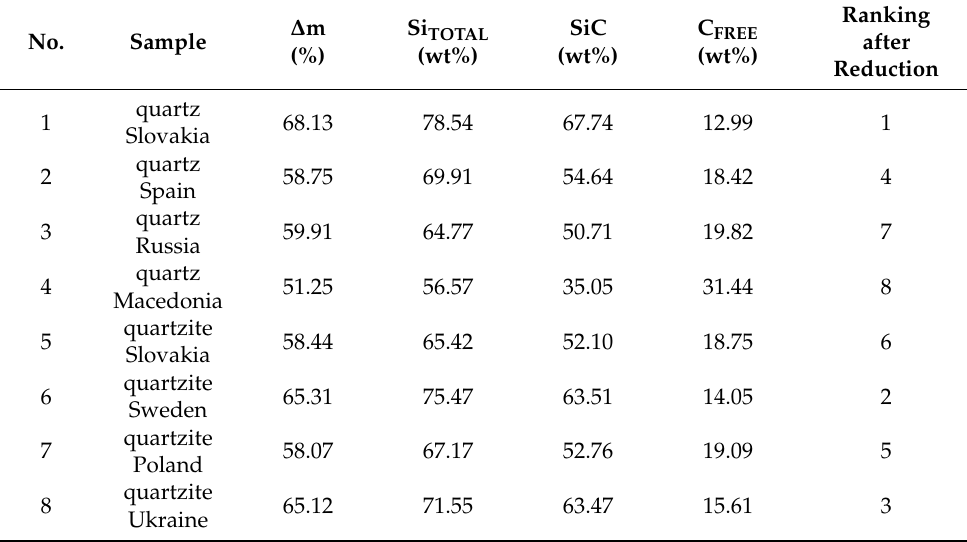
Figure 12. Schematic illustration of products after reduction of quartzite Slovakia. There was strong correlation between weight loss and Si content in the samples after carbothermic reduction; greater weight loss was also reflected in increased Si content in the reduction reaction products. There was some relation between several other parameters: e.g., the increase in reduction temperature was reflected in higher Si content in the products, and the increase in reaction time was associated with higher Si content in the products. From the point of view of comparison of the reducibility of the eight types of quartzes (or quartzites) after carbothermic reduction testing at 1750 ◦ C (milled sample, segregated), the product parameters are listed in Table 5. This table gives the ranking of the quartzes (or quartzites) after the reduction test at 1750 ◦ C. Table 5. Product parameters after carbothermic reduction test at 1750 ◦ C, 15 min (milled sample,